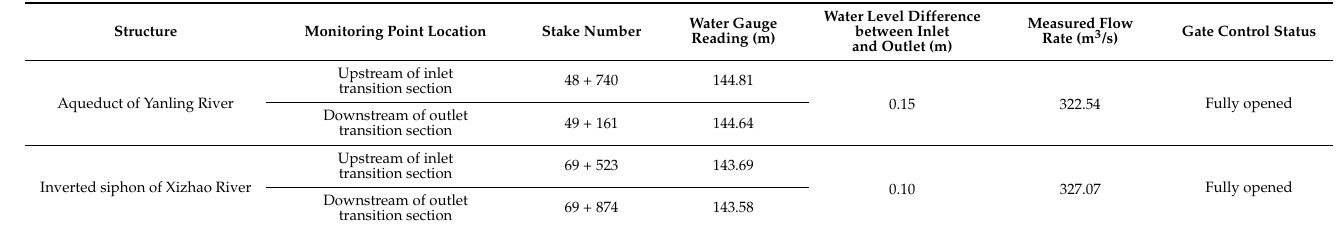
Table 1. Example of monitored water level and flow records of the project (at 16:00 on 20 May 2022).